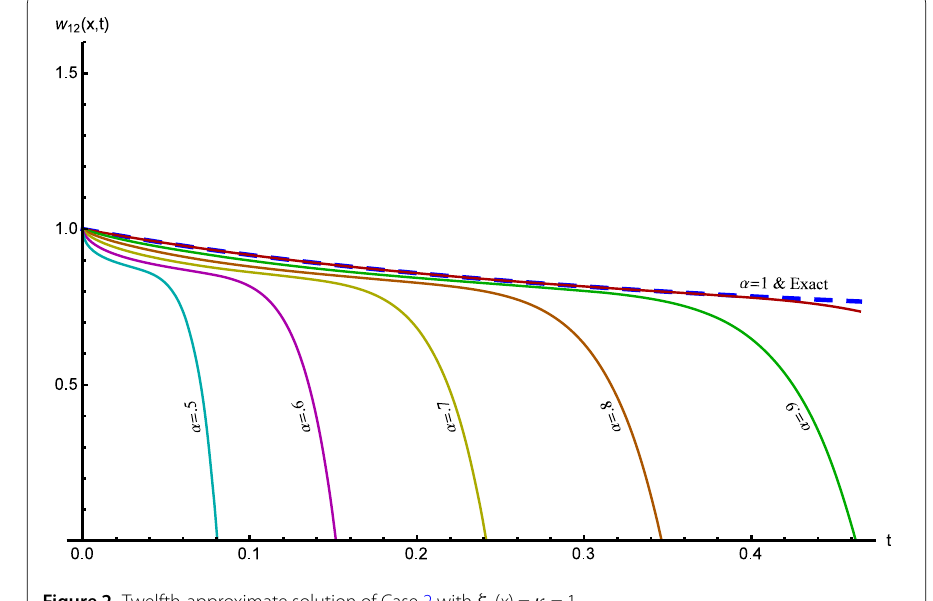
Figure 2 Twelfth-approximate solution of Case 2 with ξ 0 ( x ) = κ = 1